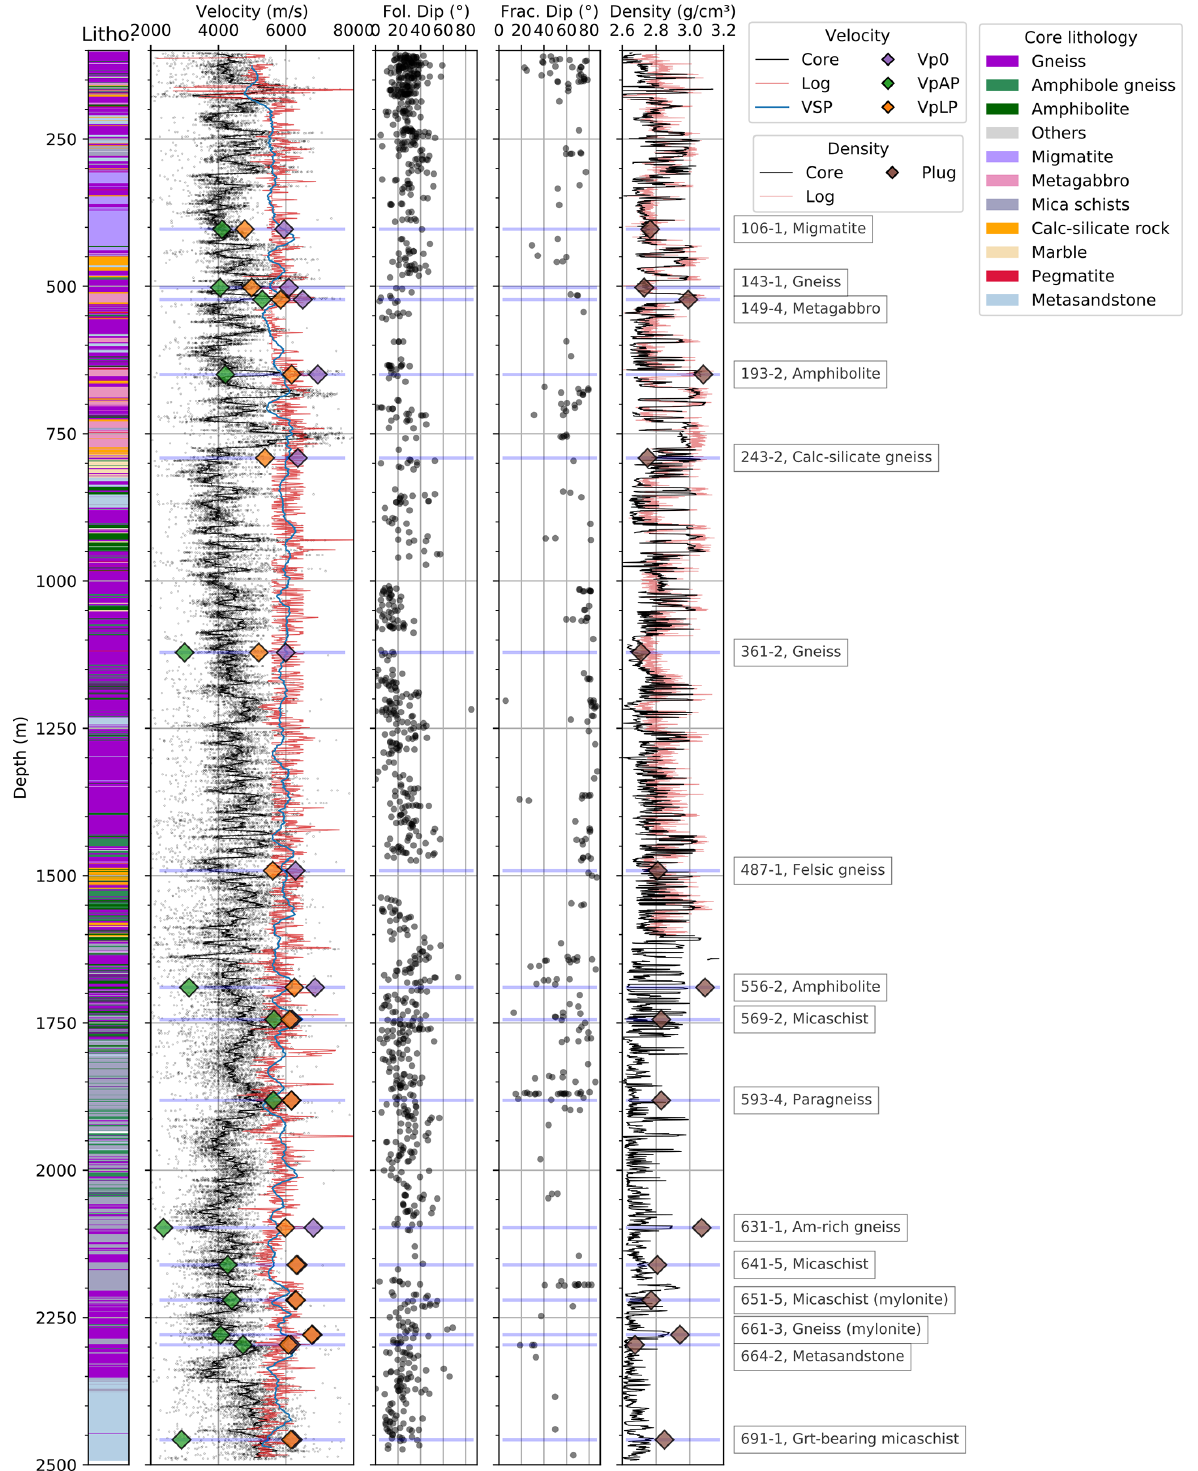
Figure 11. Core–log data integration of the seismic properties alongside with the fracture and foliation dips (Wenning et al., 2017) in the COSC-1 borehole. The sample velocity and density data are superimposed on the respective log panels. The lithology is based on the COSC-1 lithological description of the core (modified after Lorenz et al., 2015b). VSP velocities are based on the zero-offset vertical seismic profiling data (Krauß et al.,